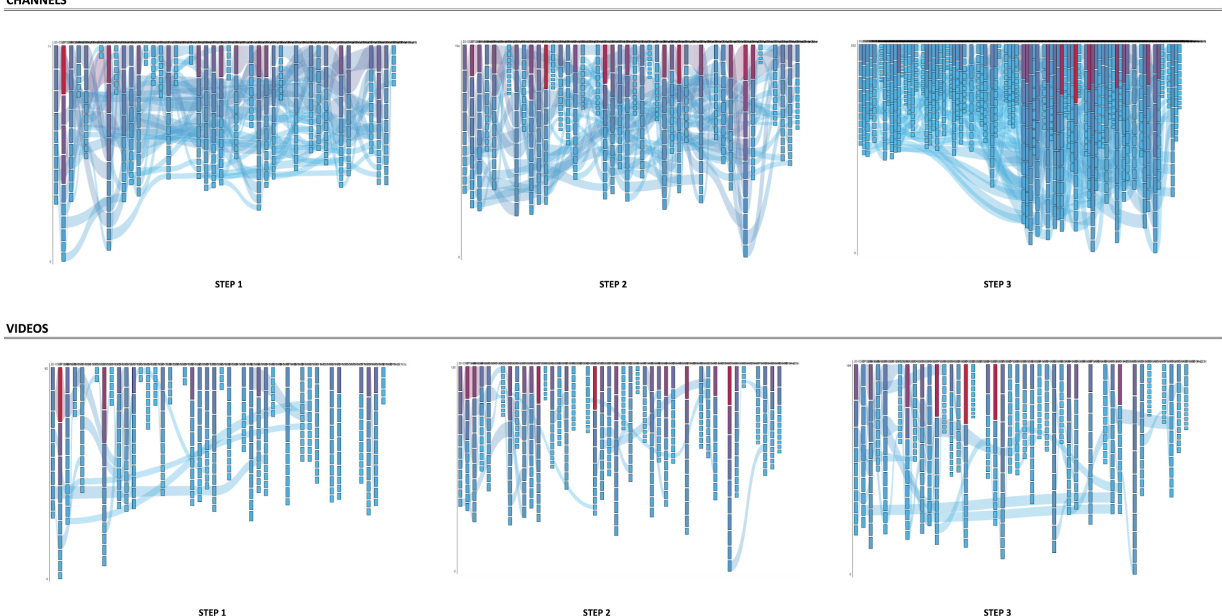
Figure 2. RankFlow visualization of “coronavirus” for the top 10 most frequently recommended channels at step 1, step 2, and step 3 (top), and for the top 10 most recommended videos at step 1, step 2, and step 3 (bottom). Notes: In the RankFlow charts, for all queries, columns represent days, and blocks individual videos or channels, ranked by number of recommendations, with the top‐ranking video or channel on top of the column; color (blue to red) and bar height both indicate the number of times a channel or video was recommended on a single day; blue, purple, and red “waves” are created when the tool identifies that a particular video or channel appears on multiple days, that is, the tool creates a flow to trace the recurrence of unique videos or channels over time; morphologies with many “waves” (see channel rank flows, step 3) indicate the presence of certain videos and channels recurrently recommended over